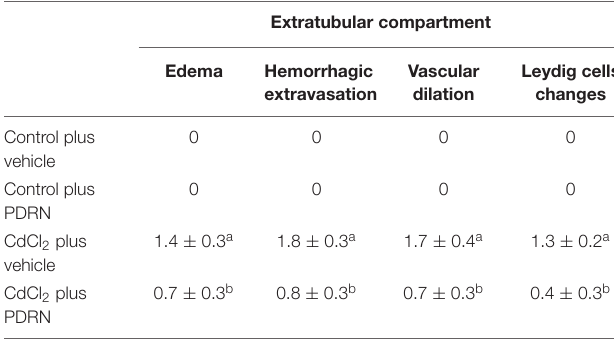
TABLE 2 | Effects on testis extratubular compartment for the two types of control animals (Control plus vehicle; Control plus PDRN) and the two types of treated ones (CdCl 2 plus vehicle; CdCl 2 plus